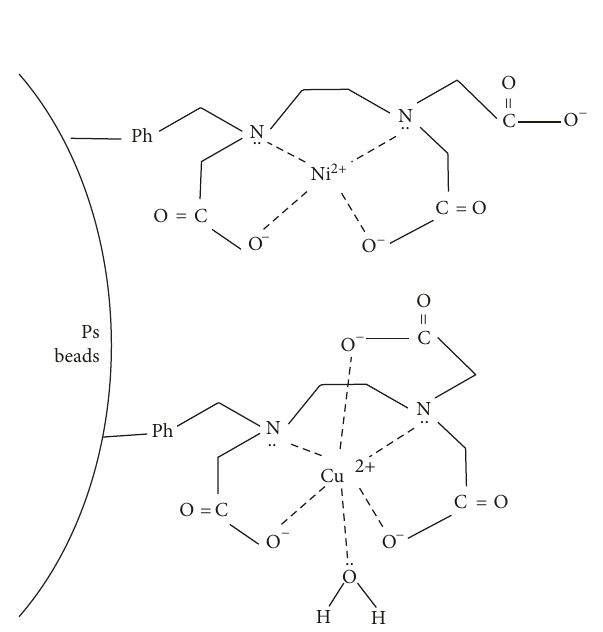
Figure 5: Trace metals ions chelated with amino polycarboxylic groups on the surface of modified PS beads.